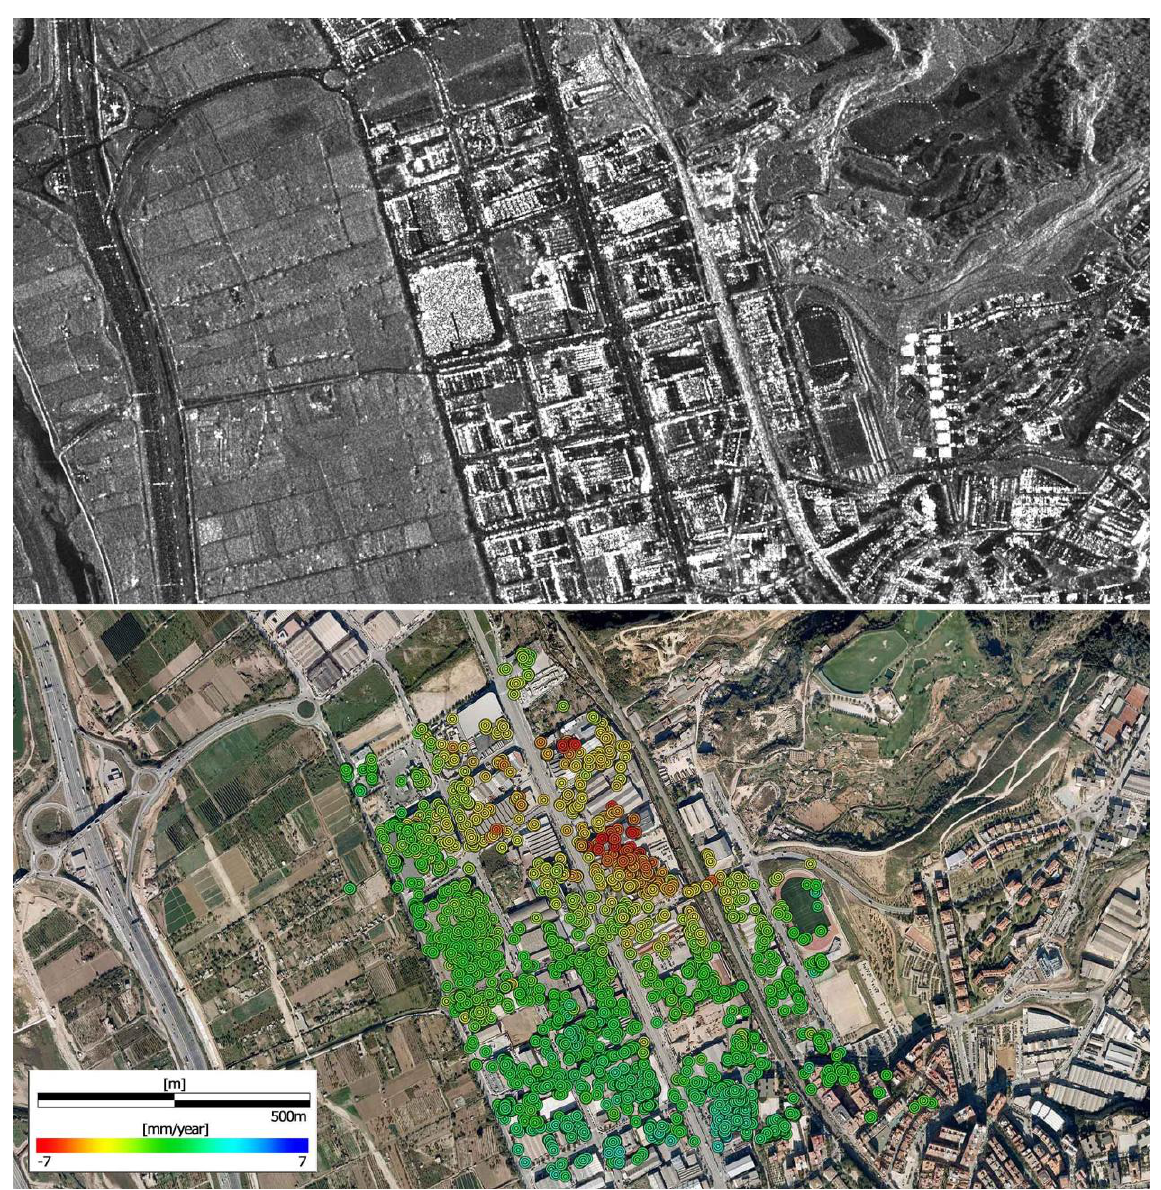
Figure 6. Mean SAR amplitude image (top) of the covered area. Geocoded deformation velocity map superimposed over a Google Earth image (© 2009 Google, Institut Cartogràfic de Catalunya) (bottom). The covered area is an industrial area of the municipality of Molins de Rei, located near